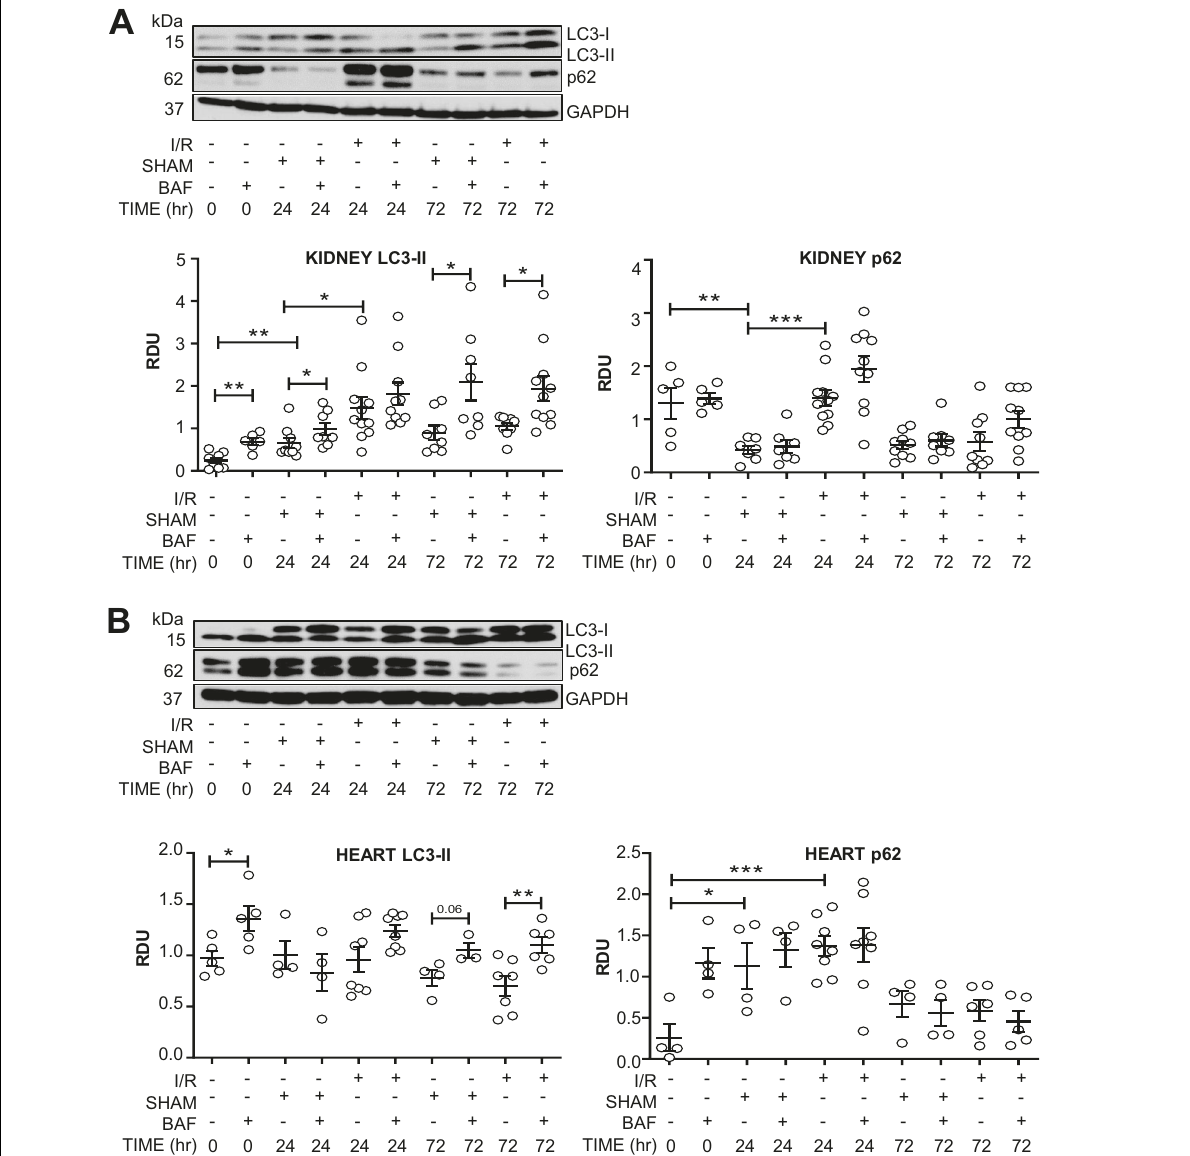
Fig. 5 Both sham surgery and bilateral renal ischemia/reperfusion (24â €‰ h) suppressed autophagic fl ux in the kidney and heart. Autophagic fl ux normalizes at 72 h. Mice underwent either no surgical manipulations, sham surgery (SHAM), or bilateral renal ischemia/ reperfusion (I/R). After 24â €‰ h or 72â €‰ h, each mouse was treated with either vehicle or BafA1 (BAF) and after 26â €‰ h or 74â €‰ h of reperfusion, the contralateral kidneys and heart were harvested. Immunoblot analysis of LC3-II and p62 in the kidney ( A ) and the heart ( B ) with representative densitometry is demonstrated. RDUâ €‰ = â €‰ relative densitometry units corrected for GAPDH. * P â €‰ <â €‰ 0.05, ** P â €‰ <â €‰ 0.01, *** P â €‰ <â € ‰